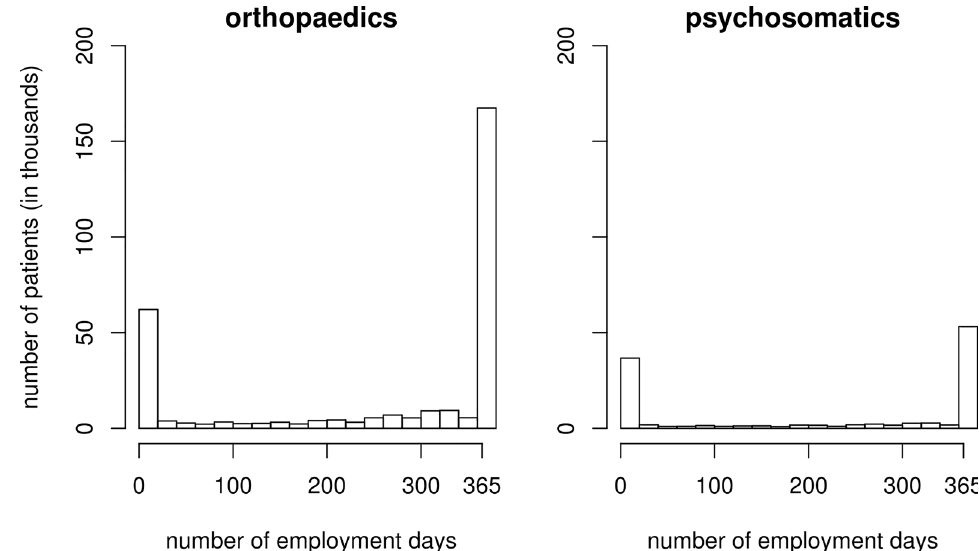
Fig. 2 Number of employment days in the first calendar year after medical rehabilitation. See text for